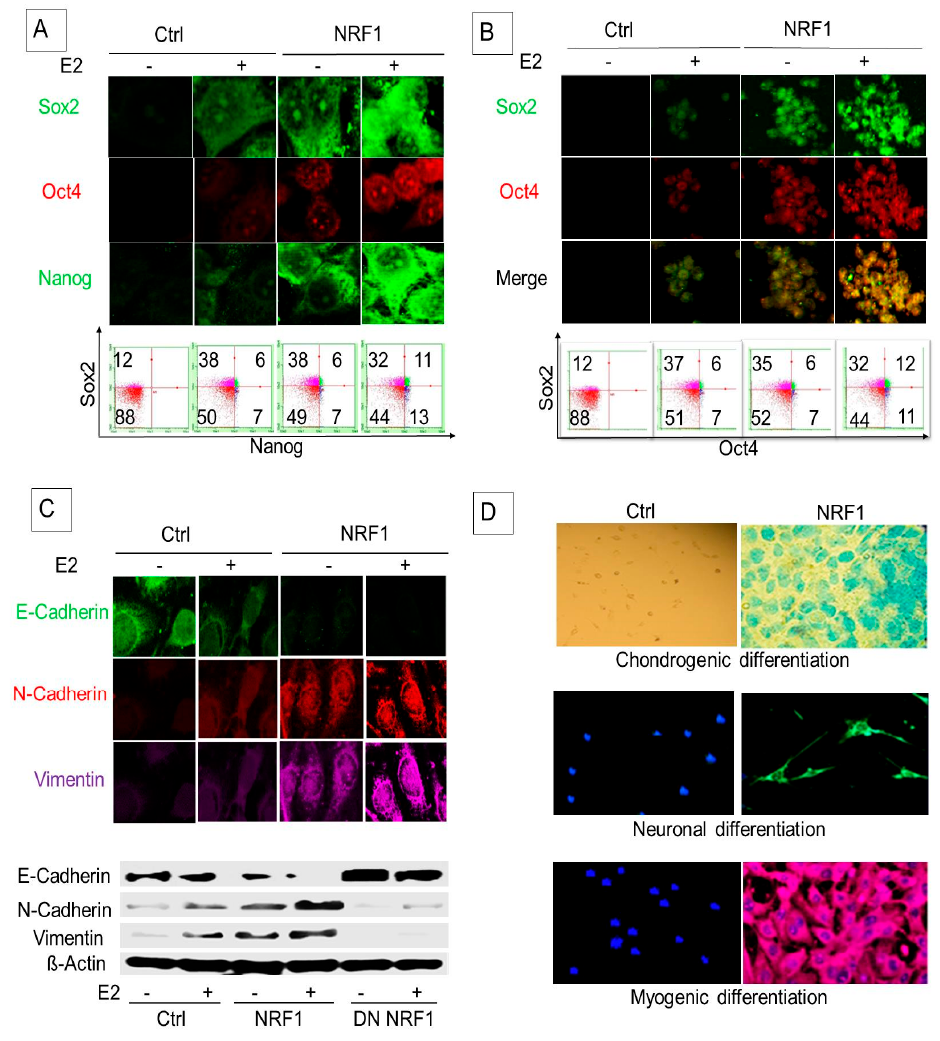
Figure 3. NRF1 and/or E2 re-programming contributed to the overexpression of pluripotency and epithelial-mesenchymal transition (EMT) markers and differentiation of tumor initiating breast cancer cells to other-types of cells. Experimental conditions were the same as Figure 1. ( A ) Immunofluorescent and flow cytometry detections of MCF10A (T) tumor initiating pluripotent stem cells markers (SOX2, Oct4, and Nanog) in transformed breast epithelial cells of MCF10A [MCF-10A (T)] overexpressing vector (control) or NRF1 treated with DMSO and E2. ( B ) Immunofluorescent and flow cytometry detections of pluripotent stem cells markers (SOX2 and Oct4) in transformed breast epithelial cells of MCF10A [MCF-10A (T)] overexpressing vector (control) or NRF1 treated with DMSO and E2. ( C ) Immunofluorescent and Western detections of the expression of EMT markers E-cadherin, N-cadherin, and vimentin in transformed breast epithelial cells of MCF10A [MCF-10A (T)] overexpressing vector (control) or NRF1 treated with DMSO and E2. ( D ) Differentiation of NRF1 tumor initiating stem cells to chondrocytes, neurons, and smooth muscle cells compared to the vector. The vector did not show any differentiation to other cells.